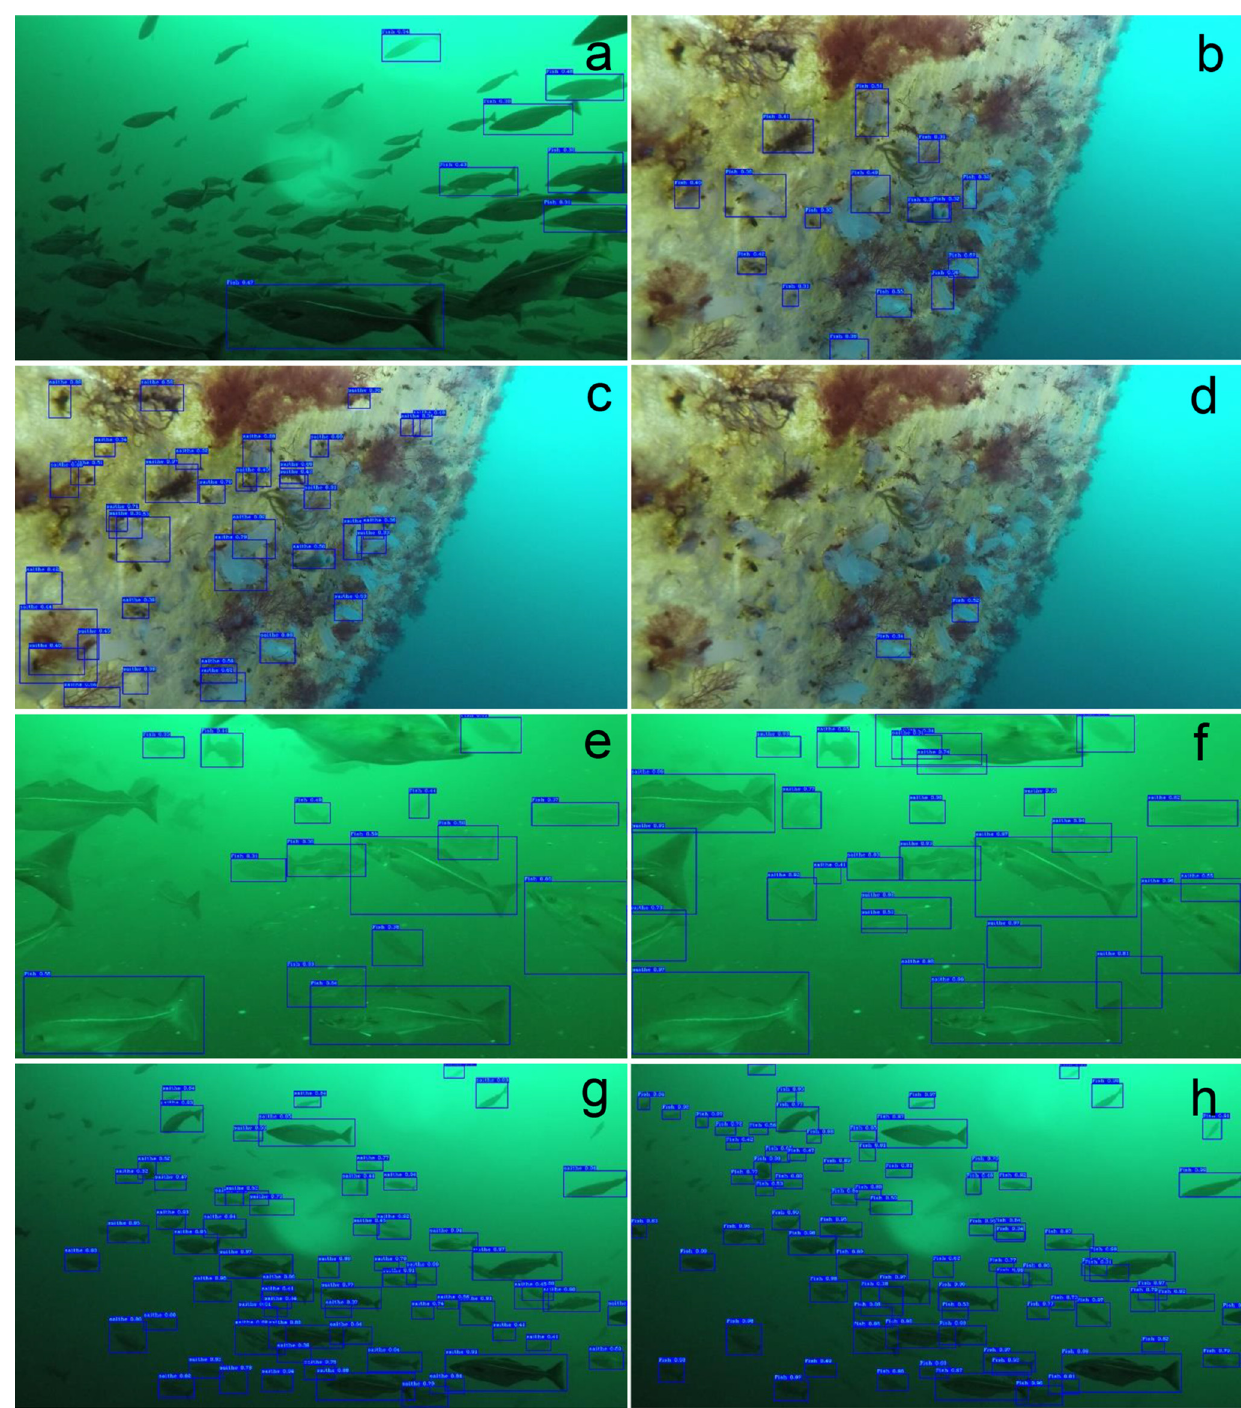
Fig. 8. Examples of images processed by the automated counting system (models). Blue boxes were placed on objects which were identified as fish by the models. Some of them were false positives (FPs). Small letters on top of the bounding boxes are confidence scores. Any predicted bounding boxes with confidence scores below 30% were discarded. Large numbers of (a) false negatives (FNs, fish which were not in the blue bounding boxes) and (b) false positives (biofouling organisms in the blue bounding boxes) by Model 1. (c) Model 2 still had large registration of FPs; (d) Model 3 had fewer FPs. (e) Model 1 had some FNs, but these were fewer in (f) Model 2. (g) Model 2 and (h) Model 3 detected objects that were not counted as fish by manual work, which resulted in increased FPs (some of the blue bounding boxes on the small blurred